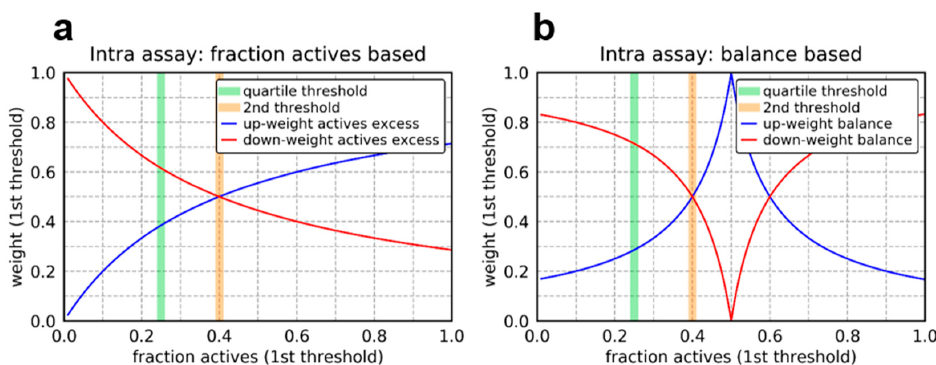
Figure 7. Visualization of intra assay weighting functions for the first threshold assuming a fraction of actives of 0.4 for the second threshold: ( a ) fraction actives based weighting and ( b ) balance based weighting.